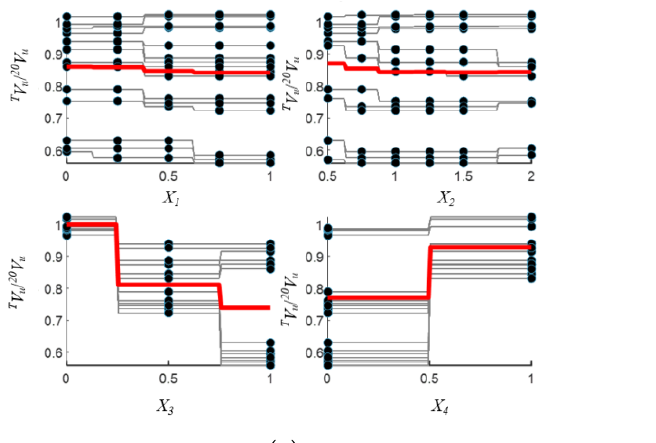
Figure 6. Shear load-midspan displacement curves of P-1-250 with different exposure temperatures and cooling methods.